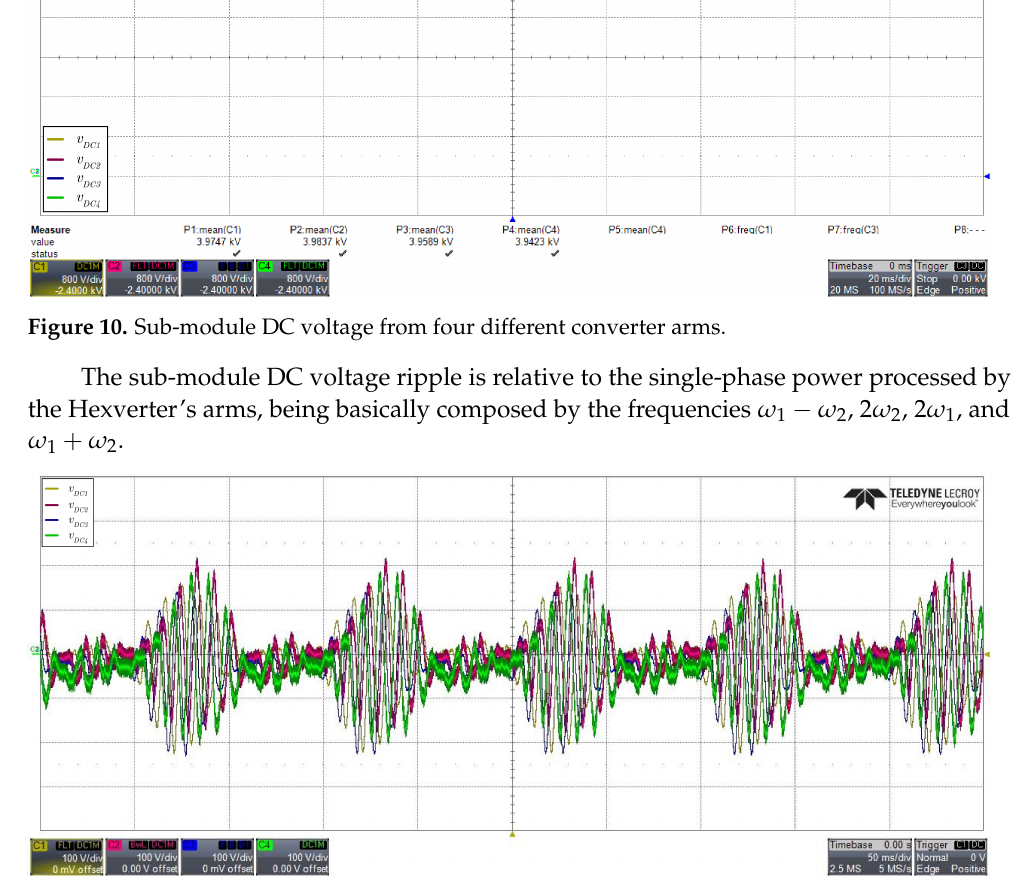
Figure 11. Sub-module DC voltage ripple from four different converter arms, showing only the voltage alternating components.